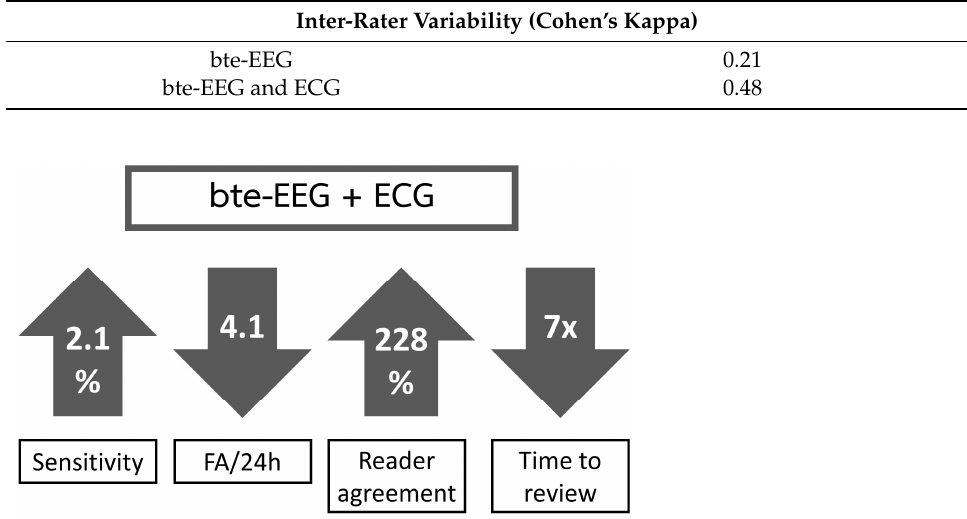
Table 3. Inter-rater variability between the two readers for each experimental setup.